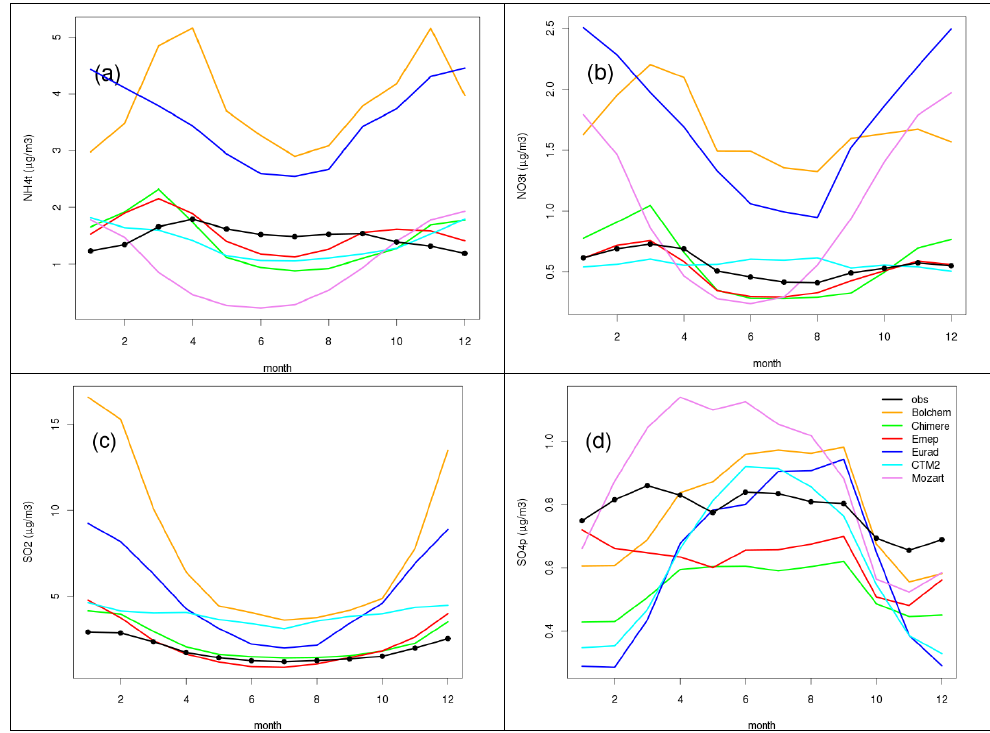
Figure 6 : Same as Figure 4 for total NH 4 t (a), total NO 3 t (b), SO 2 (c) and SO 4 p (d) recorded at EMEP background stations. Fig. 6. Same as Fig. 4 for total NH 4t (a) , total NO 3t (b) , SO 2 (c) and SO 4p (d) recorded at EMEP background